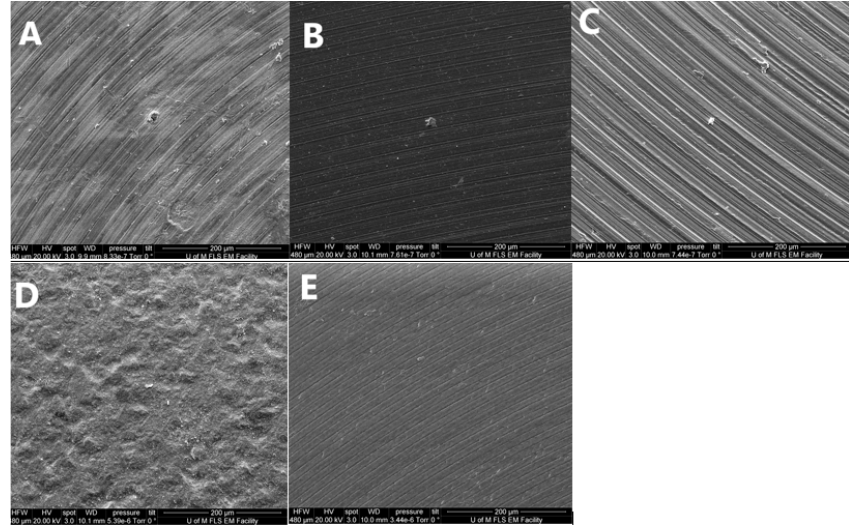
Figure 3. SEM images showing the surface of the investigated materials ( A ): Ti, ( B ): TiN, ( C ): CoCr, ( D ): ZrO 2 , and ( E ): m-PEEK).